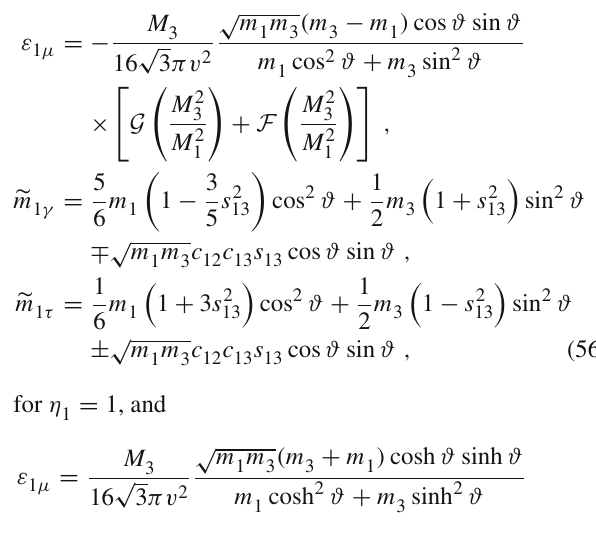
Fig. 6 Upper: in the TM1 μ - τ reflection symmetry scenario, the lower bound on M for leptogenesis to be viable as functions of the lightest 2 neutrino mass in the NO ( a ) and IO ( b ) cases. The red and blue solid (dotted) lines respectively correspond to η < M < M M ( M ). Lower: in the TM2 μ - τ reflection symmetry 2 1 1 2